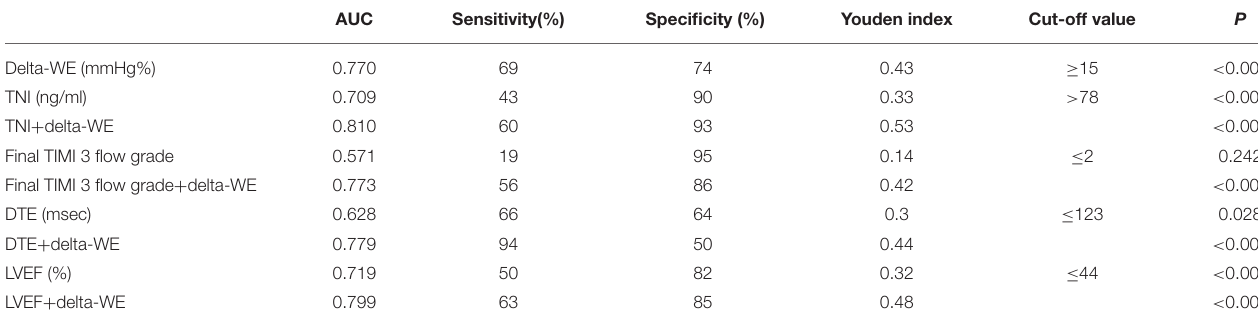
TABLE 5 | Receiver operating characteristic analysis of different models for predicting early left ventricular remodeling in anterior STEMI patients.